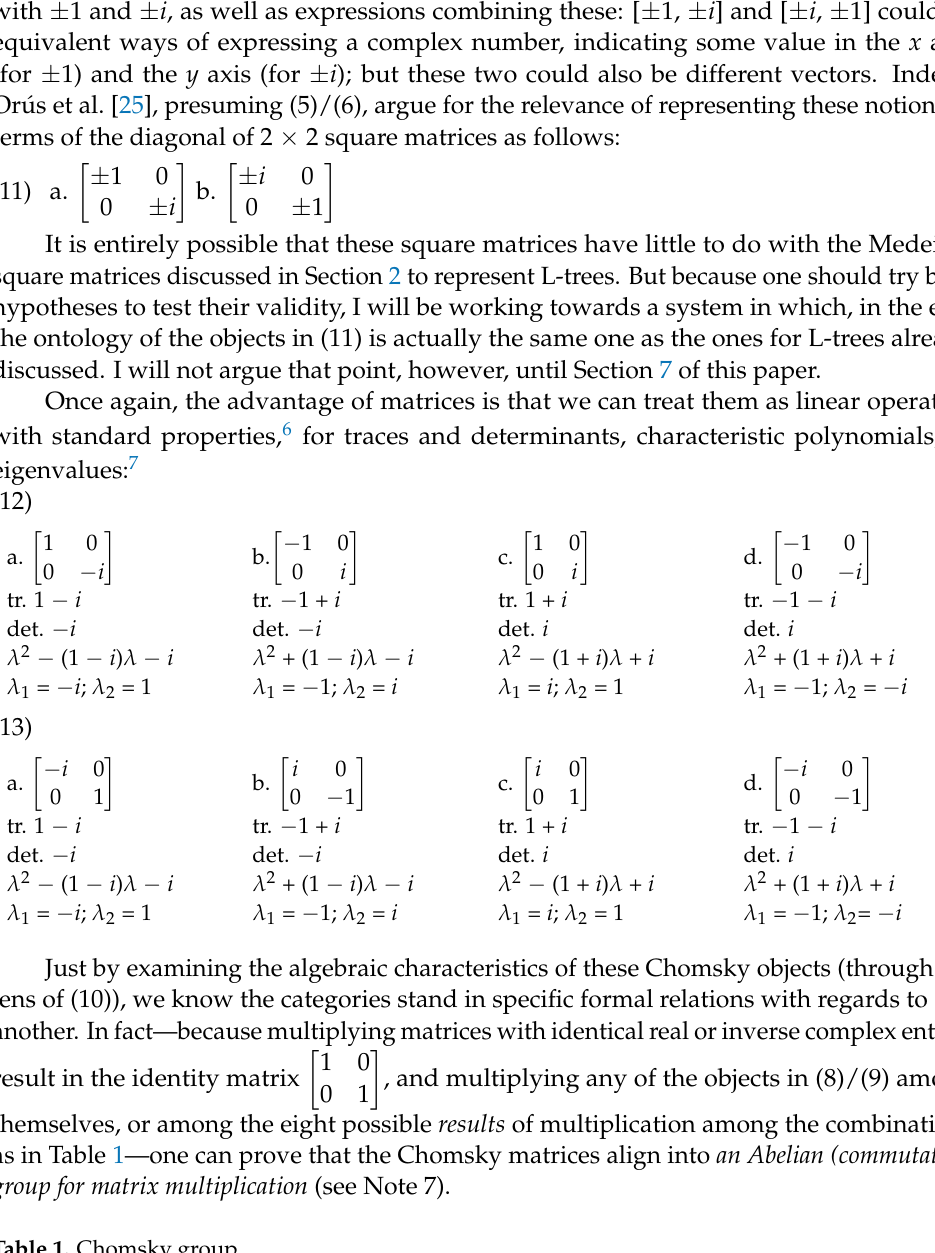
Table 1. Chomsky